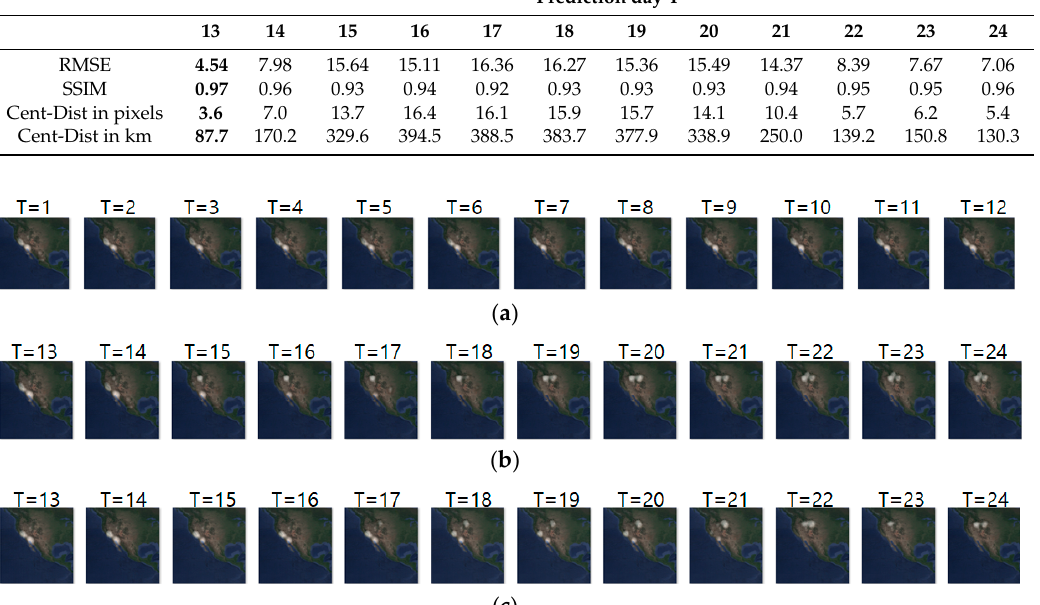
Table 16. Daily comparison of RMSE, SSIM, and centroid distance of case 10.